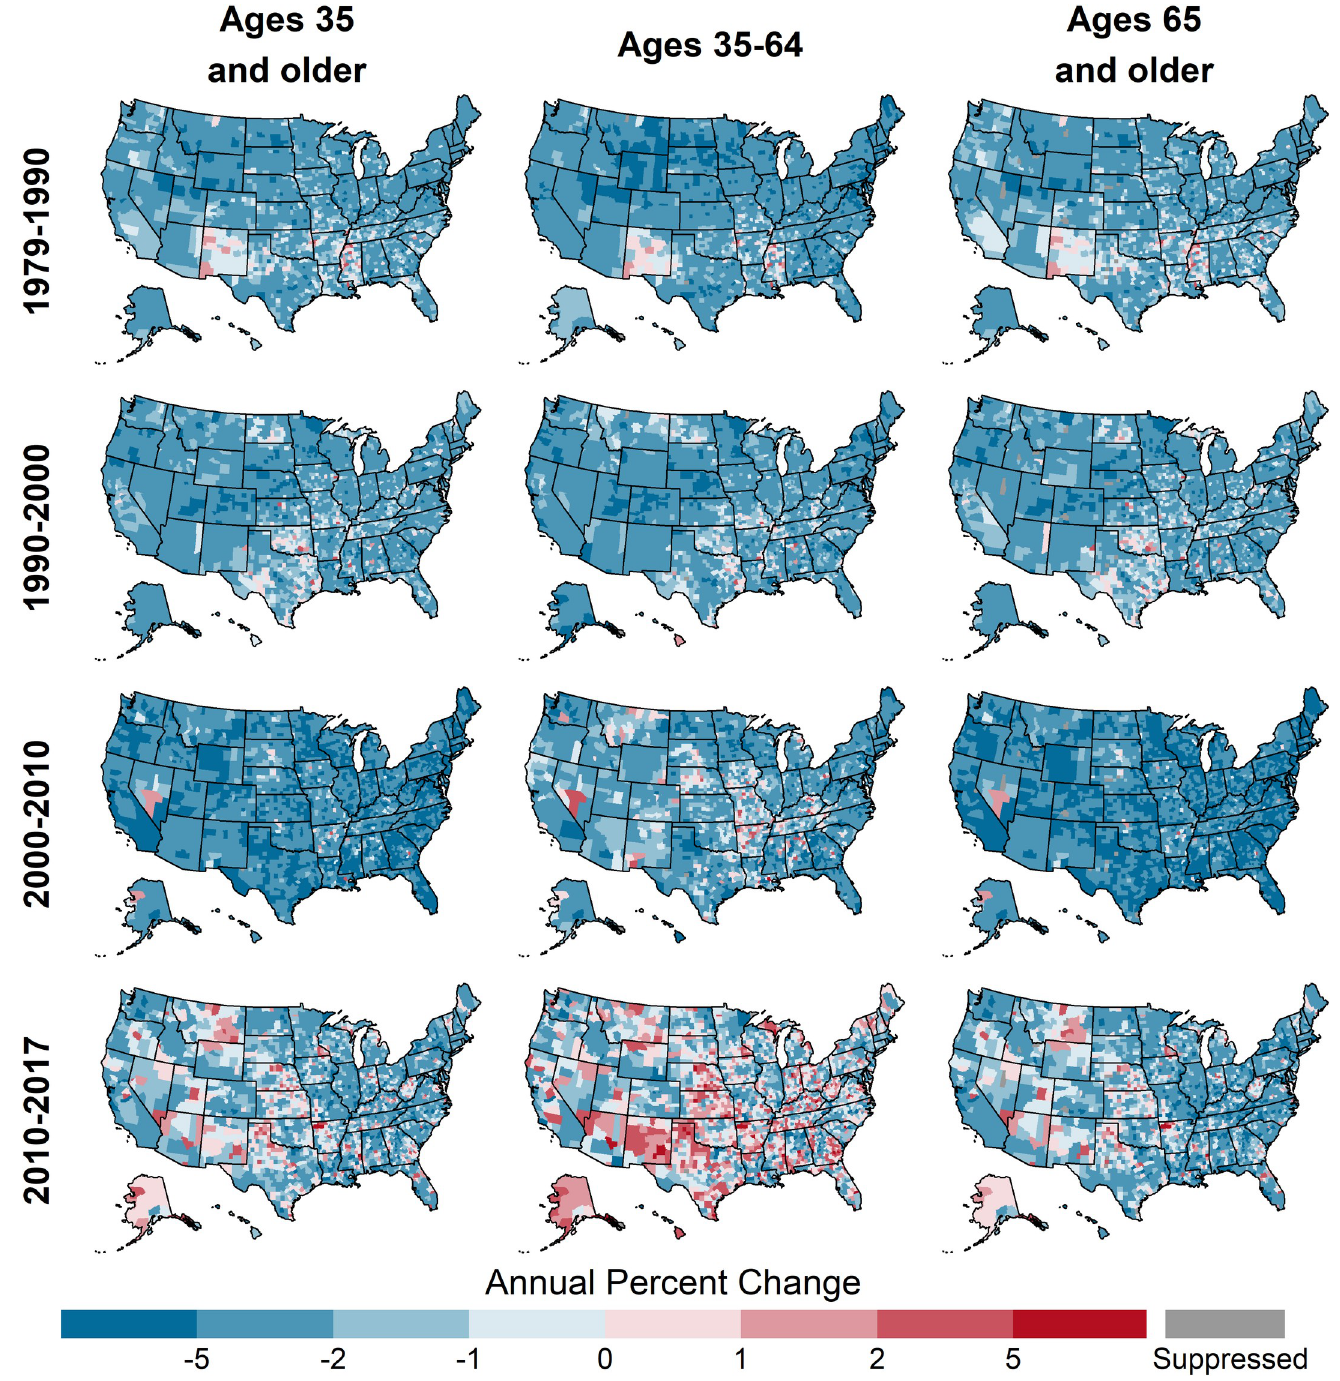
Fig 5. Annual percent change in county-level CHD death rates by year and age group, United States,